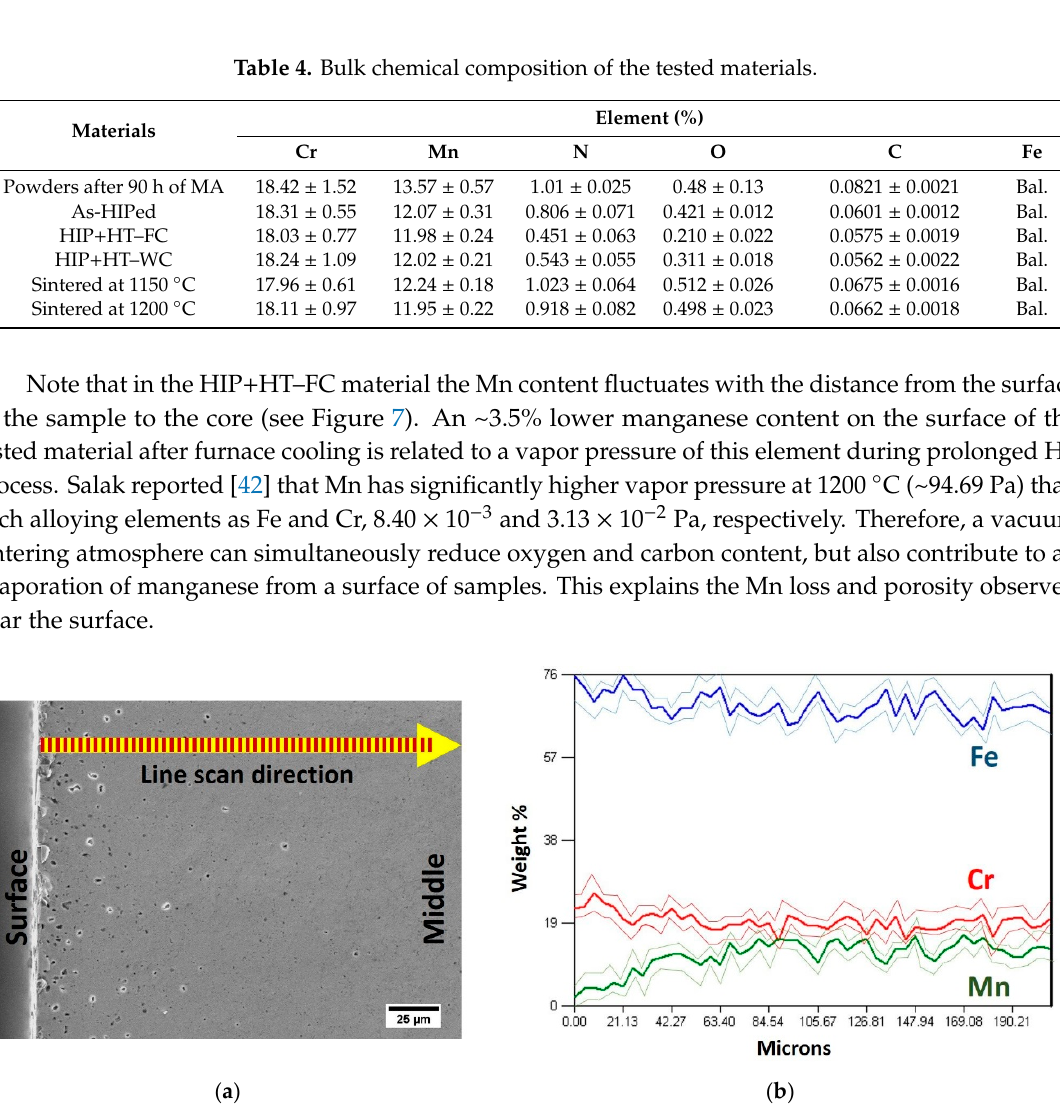
Figure 7. ( a ) Scanning Electron Microscope (SEM) image with an Energy Dispersive Spectroscopy